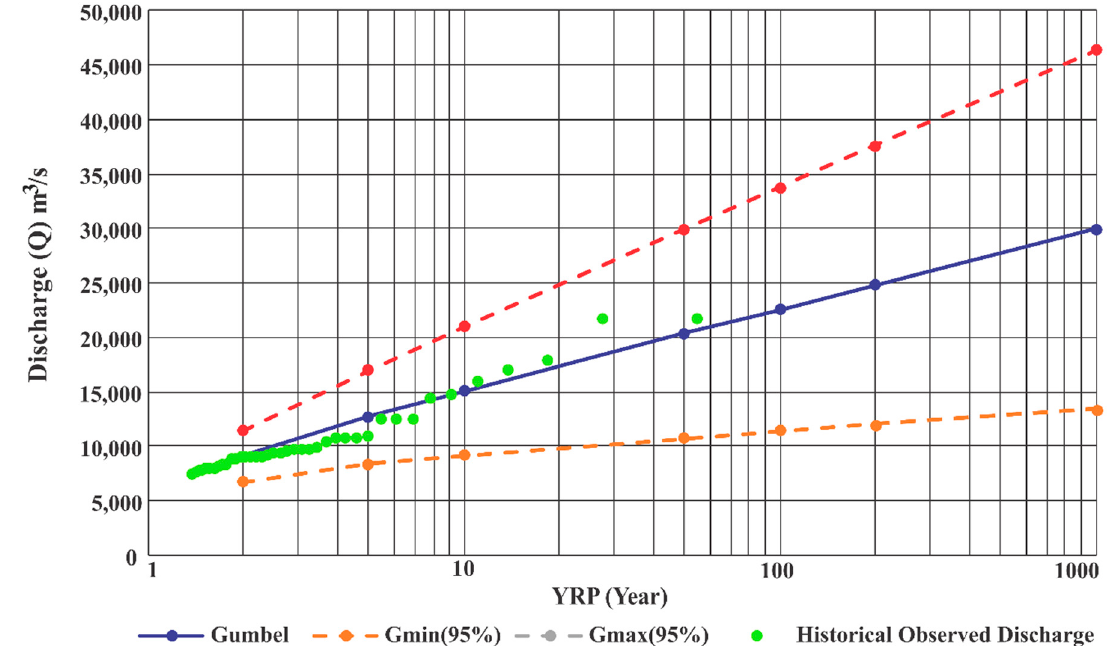
Figure 7. Frequency analysis of flood discharge at Chisapani gauge, showing the Gumbel’s distribution and its 95% confidence limits of extreme values (calculated using the standard normal distribution). The year return period (YRP) is plotted on a logarithmic scale for clarity. Historically observed discharge is also given here for reference.